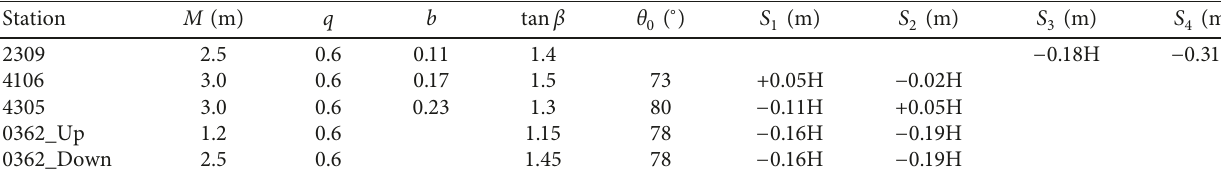
Figure 13: Diagrammatic sketch for PIM parameters of inclined coal seam (© reproduced from Li et al. [22] under the Creative Commons Attribution License (CC BY-NC-ND Table 1: PIM parameters of Nantong Coal Mine.